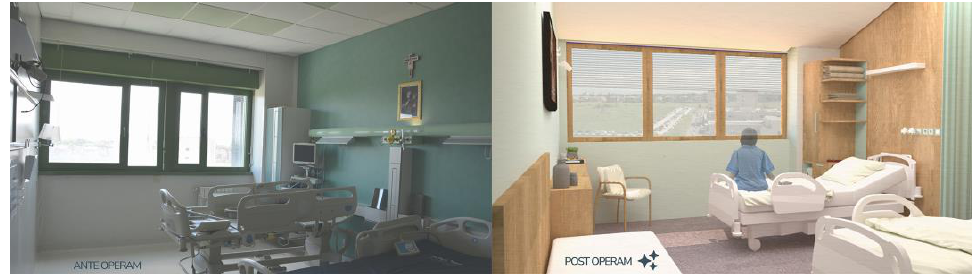
Figure 19. Ante operam and post operam comparison, room 2.